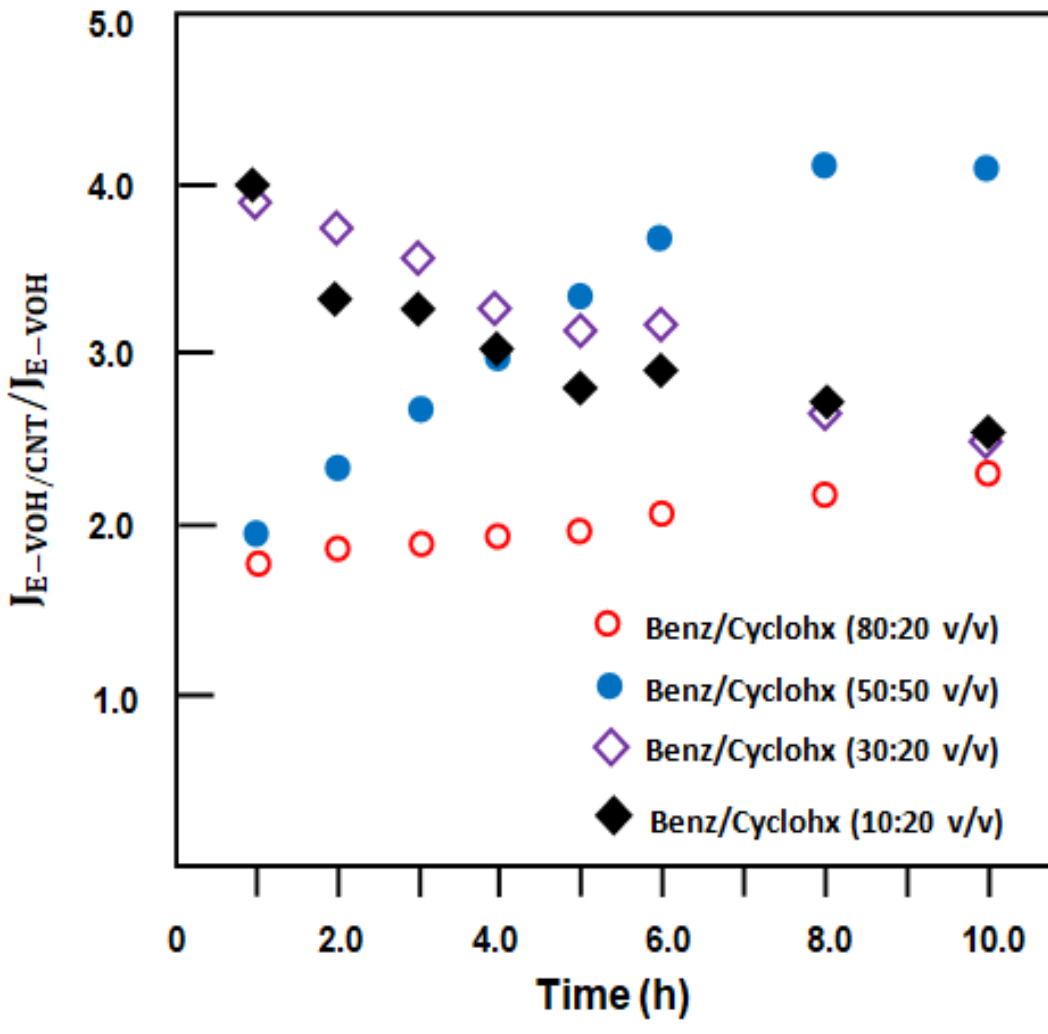
Figure 16. Variation of the J E − VOH / CNT / J E − VOH ratio versus time for the different feed compositions.